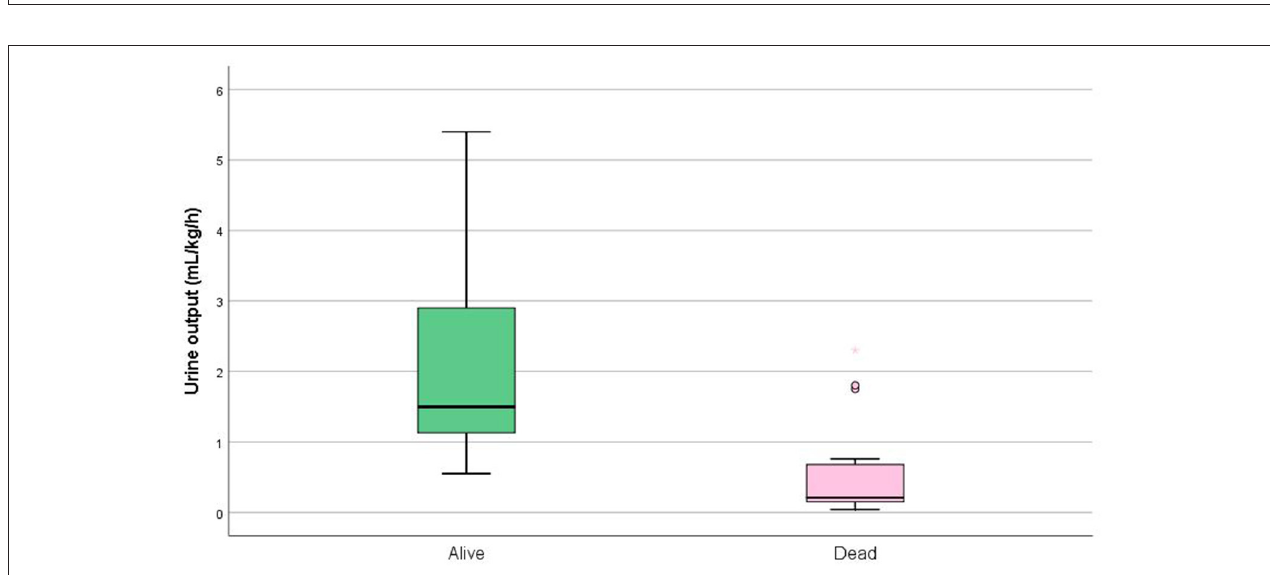
FIGURE 5 | Kidney function according to urine output in patients receiving ECMO. Tukey boxplot, whiskers represent 1.5 interquartile range ( p =